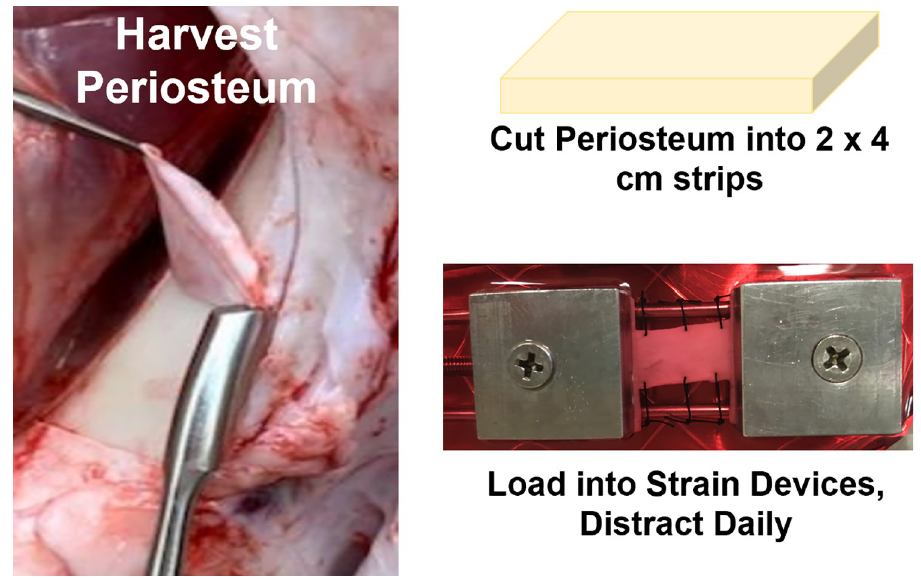
Fig 1. Harvesting of periosteum from the tibia of red Duroc pigs using a periosteal elevator. Periosteum was cut into 2 x 4 cm strips and loaded into custom made 316L stainless steel strain devices with long-axis edges constrained in the lateral direction using